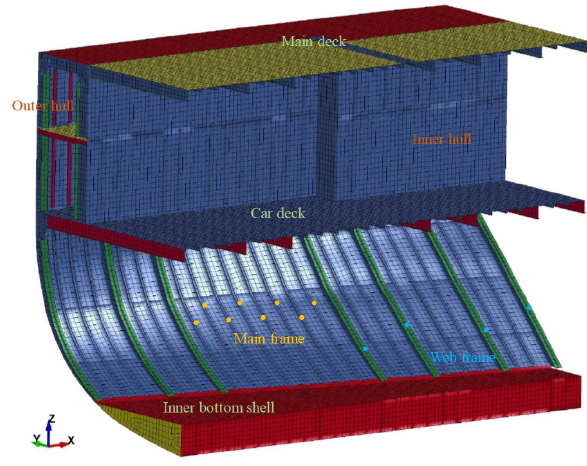
Figure 3: Numerical model of the hull structures. Modelling is fo- cused on the side structures